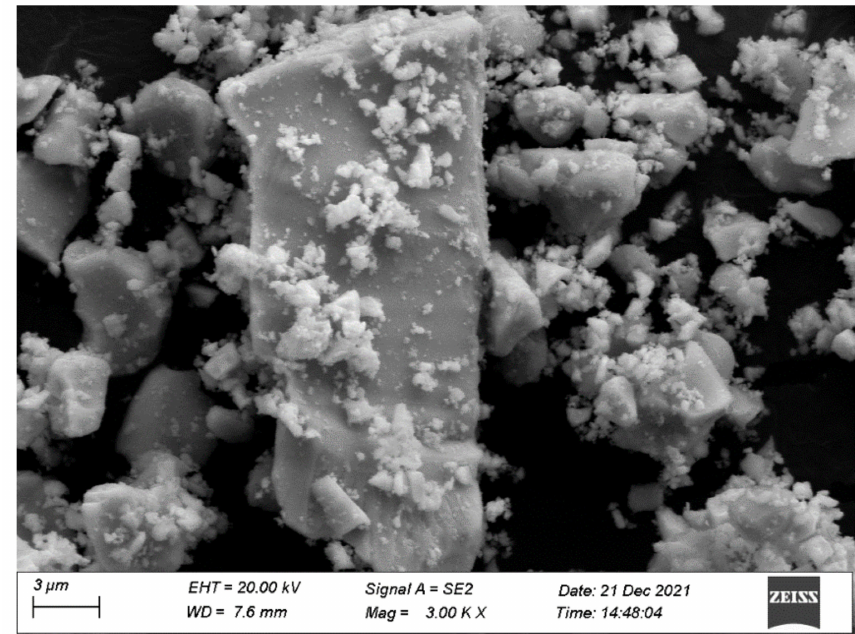
Figure 9. SEM photograph of Bi 2 SmSbO 7 /ZnBiYO 4 heterojunction